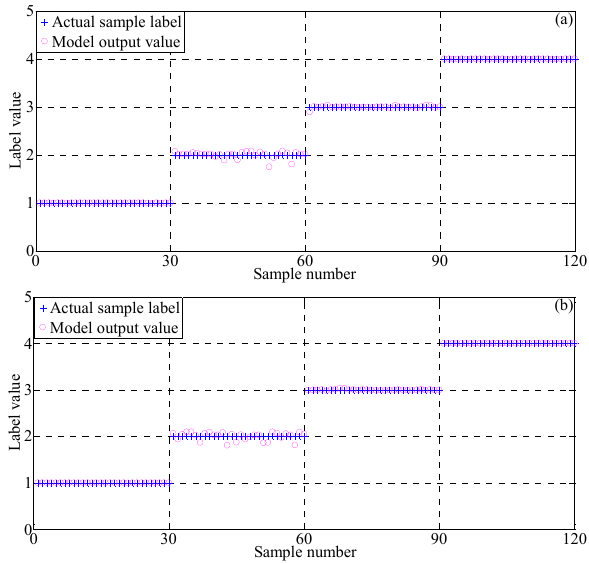
Figure 11. ( a ) Training results and ( b ) testing results of gearbox dataset by SDAE. Table 7. Recognition results of gearbox health status obtained by SDAE and DBN.